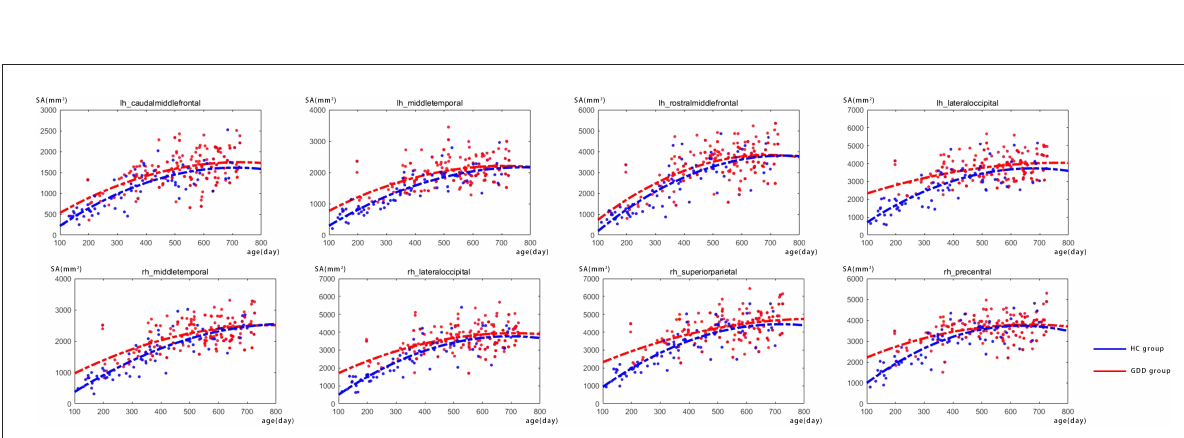
on the average central cortical surface of the age-matched left